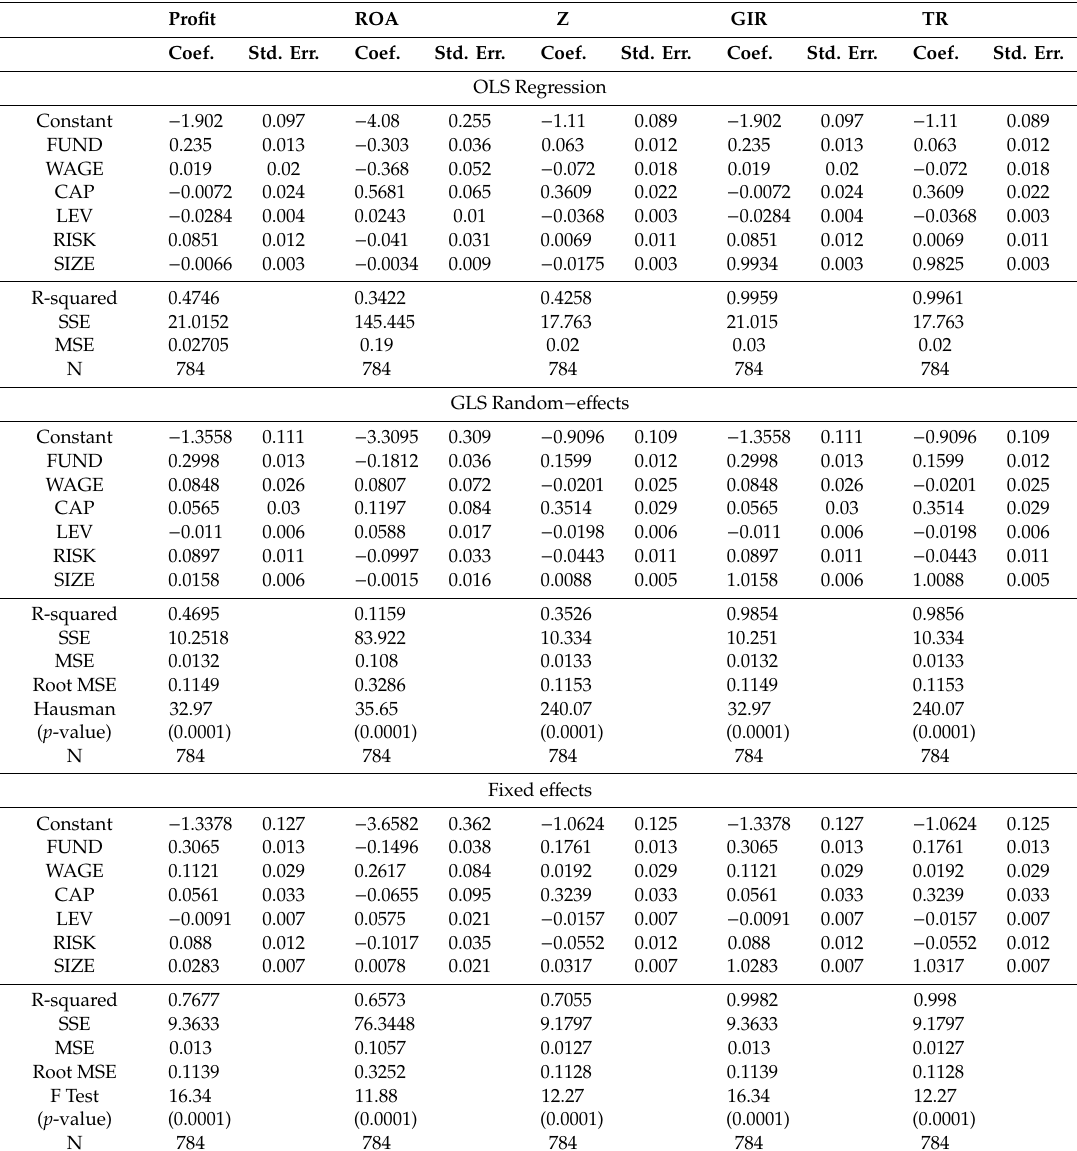
Table A4. Regression of control variables. ( A ) ALL BANKS; ( B ) PUBLIC BANKS; ( C ) PRIVATE BANKS; ( D ) FOREIGN